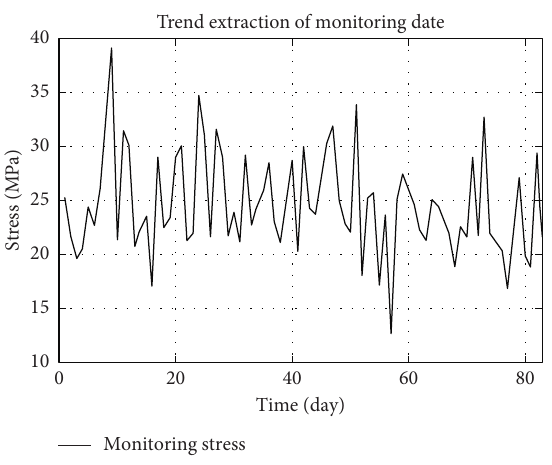
Figure 1: Monitored stress for 83 days.